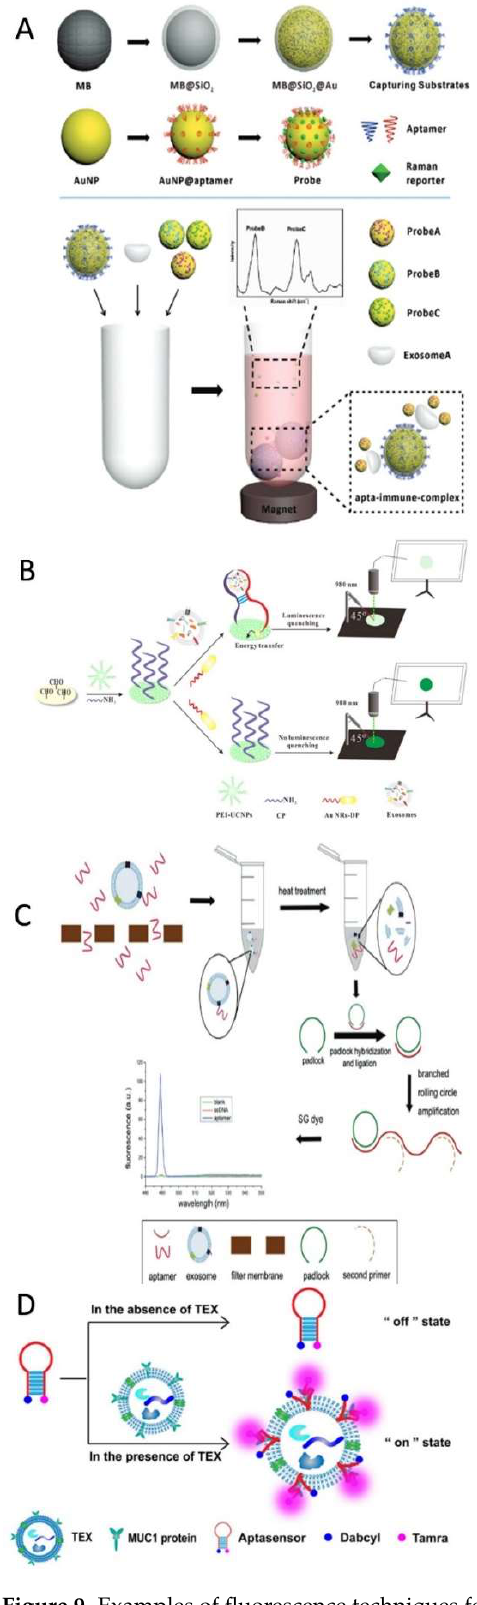
Figure 9. Examples of fluorescence techniques for exosome detection and quantification. The